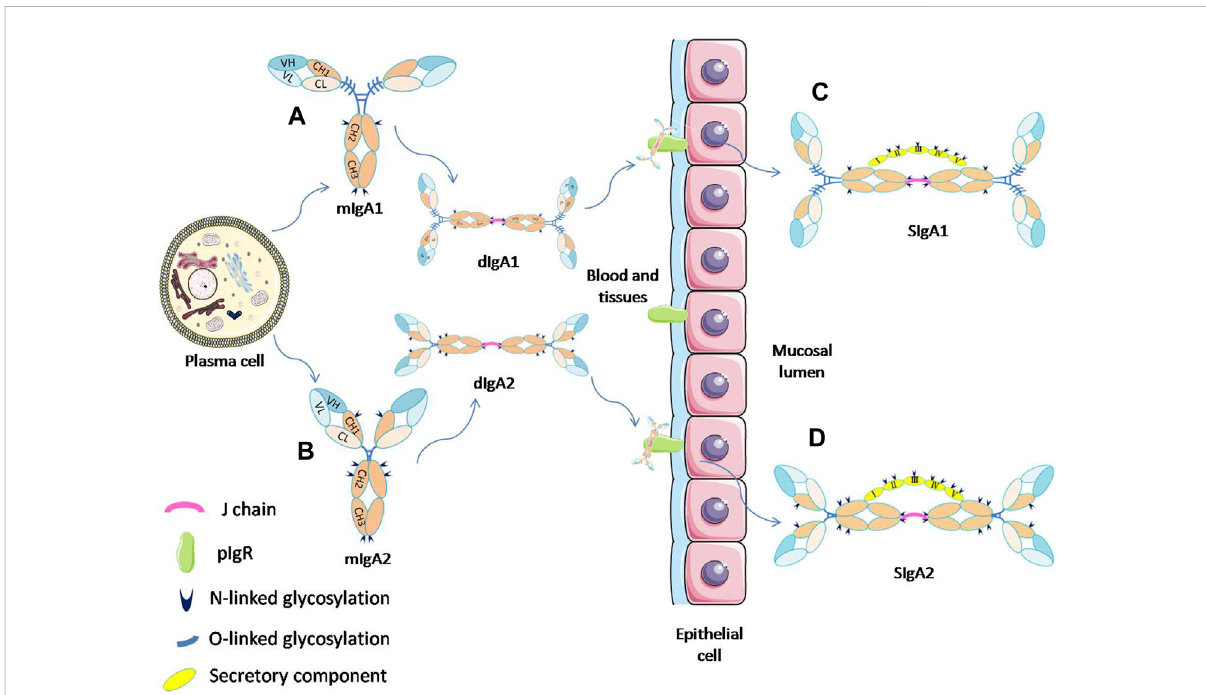
FIGURE 1 SchematicdiagramoftheprocessofSIgAformationbymIgAanditsglycosylationsites.IgAmonomers (A,B) presentinthemucosalplasmacells can form dimmers through the J-chain. The dIgA is then transported across the epithelium by binding to pIgR. At the luminal side, dIgA is released from the pIgR, and a part of the receptor (SC) remains attached to dIgA to form SIgA (C,D) . (Davis et al., 2020; van Gool and van Egmond,